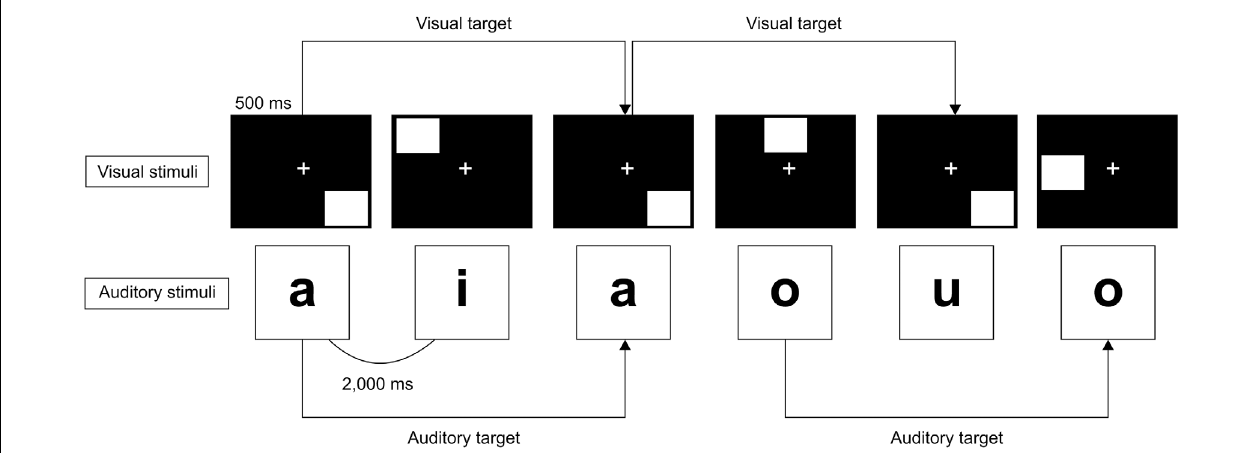
FIGURE 1 | Dual 2-back task. The auditory-verbal and visuospatial stimuli are presented simultaneously and consecutively. The participants are required to answer whether the current stimulus is the same as the stimulus presented two times back as quickly and accurately as possible for each stimulus. Each stimulus was presented for 500 ms, and the interstimulus interval was 2,000